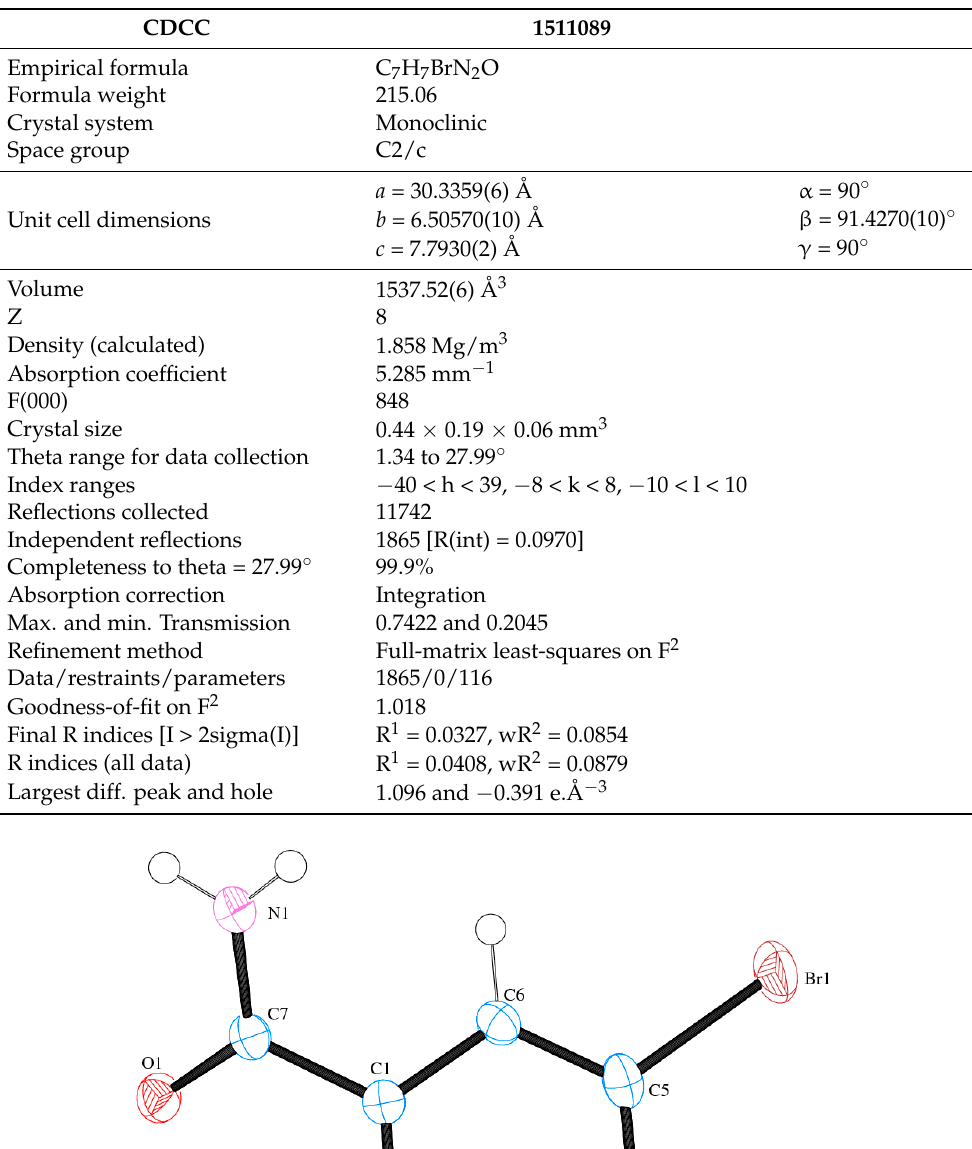
Table 5. The crystal data and structure refinement for ABB .